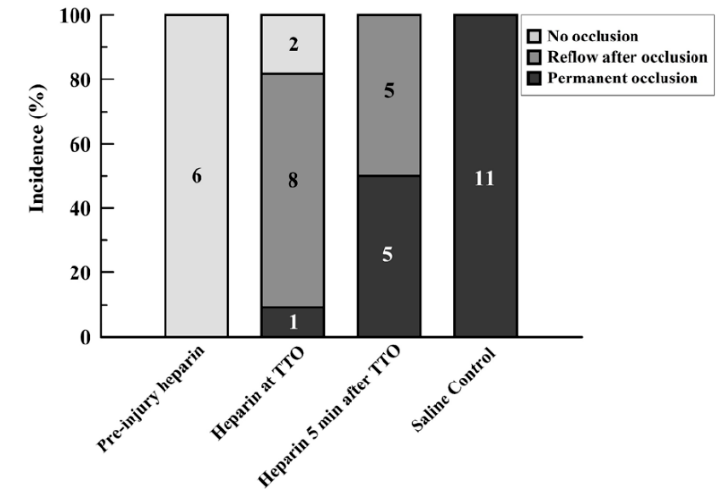
Figure 2. Bar graph showing incidence of events after FeCl 3 injury for the four study groups. Events were separated into three categories: no occlusion, reflow after occlusion, and permanent occlusion. Values are expressed in percent proportion, with the numbers within bars showing the number of runs for each group with each particular event criterion.